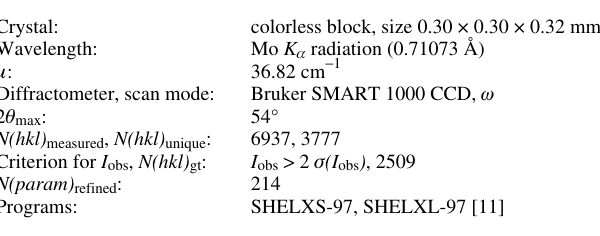
dimer. Table 1. Data collection and handling.